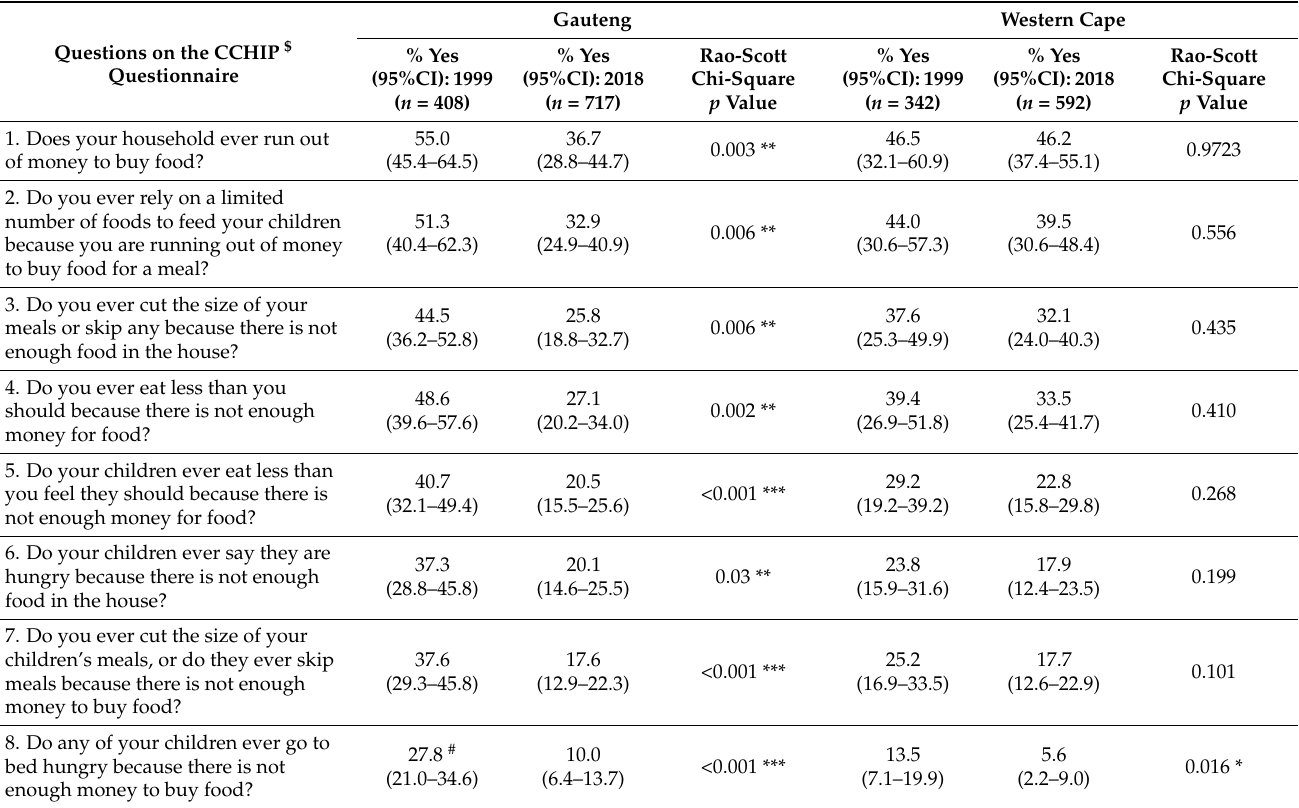
Table 3. Comparison of results for individual questions on the hunger questionnaire $ between households of 1–<10-year-old children in Gauteng and Western Cape provinces in 1999 and